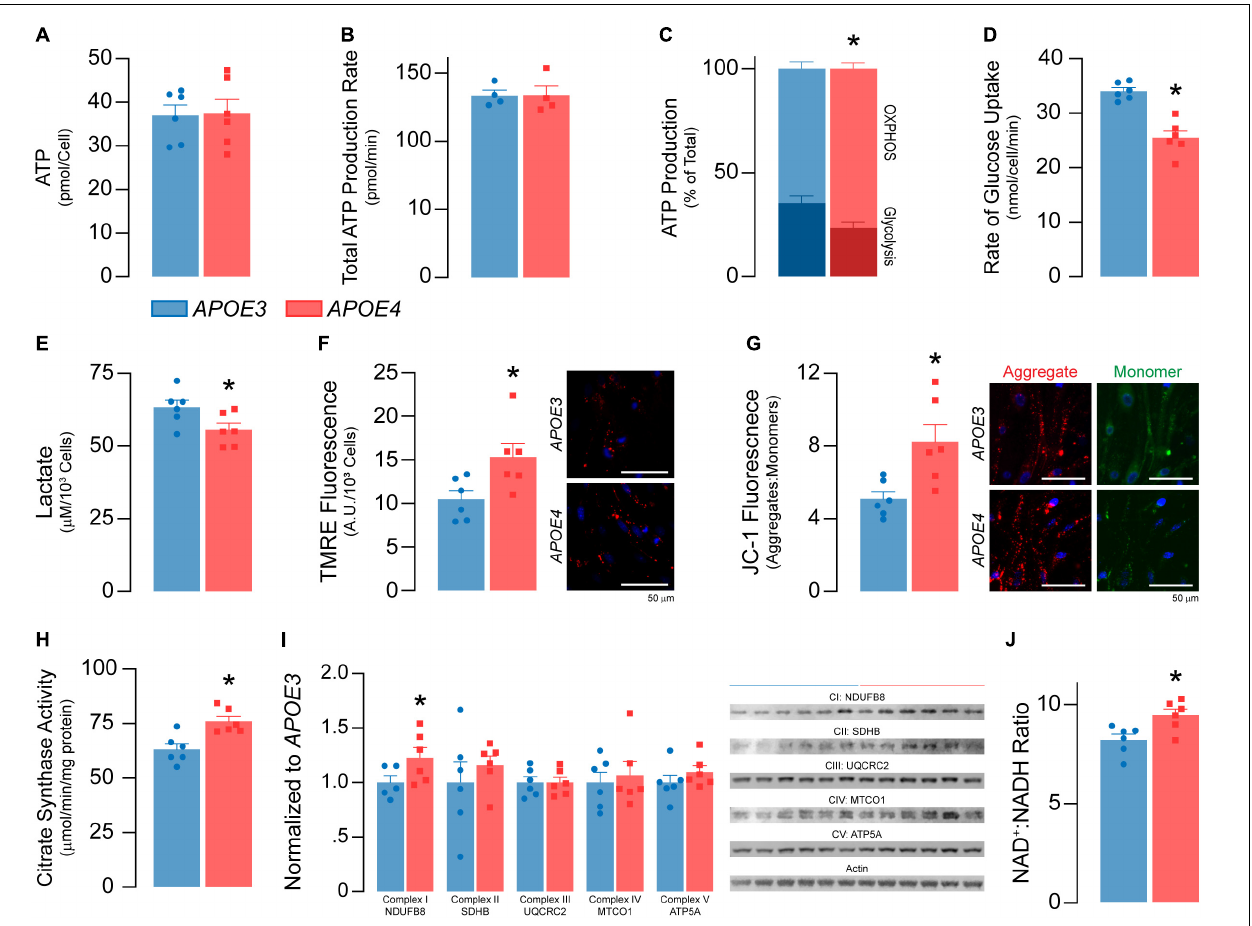
FIGURE 4 | APOE4 brain endothelial cells have lower glycolysis and higher oxidative phosphorylation and mitochondrial activity compared to APOE3 . (A) ATP levels and (B) the rate of total ATP production ( n = 4) are similar in APOE3 and APOE4 brain endothelial cells. Glycolysis and mitochondrial oxidative phosphorylation (OXPHOS) both contribute to ATP production. Comparing the bioenergetic profiles of APOE3 and APOE4 brain endothelial cells revealed (C) ATP production from OXPHOS is higher and glycolysis is lower with APOE4 as measured by Seahorse XF Real-Time ATP Rate Assay ( n = 4). Consistent with lower glycolytic activity, APOE4 brain endothelial cells also have (D) a lower rate of glucose uptake and (E) lower levels of lactate in the media compared to APOE3 . Mitochondrial activity is central to OXPHOS, which may be higher with APOE4 . We measured mitochondrial activity using complementary approaches. Active mitochondria have a greater net negative charge that can be measured by the accumulation of tetramethylrhodamine ethyl ester (TMRE) and aggregation of JC-1 (monomer, green; aggregate, red) dyes. In APOE4 brain endothelial cells there is (F) higher TMRE staining ( ∼ 46%) and (G) aggregate:monomer ratio of JC-1 ( ∼ 62%). (H) Citrate synthase activity, which is important for the first step of the Krebs cycle, is also higher with APOE4 ( ∼ 20%), as are transcripts of electron transport chain components (e.g., mt-Nd1, mt-Nd2, mt-Nd4, mt-Nd5, mt-Cytb, mt-Co1 Supplementary Table 2 ), which (I) we validated at the protein level. (J) Nicotinaminde adenine dinucleotide (NAD) is a co-factor present in two forms in a cell; NAD + (oxidized) and NADH (reduced). NADH is utilized in the electron transport chain to donate electrons for ATP generation and as a co-factor for enzymatic activity. The ratio of NAD + :NADH is higher with APOE4 , data that may imply lower NADH levels to supply the cell with energy, or that high levels have been oxidized to sustain higher mitochondrial function. Data is expressed as mean ± S.E.M. * p < 0.05 by Student’s t -test with n = 6 (unless otherwise specified above).